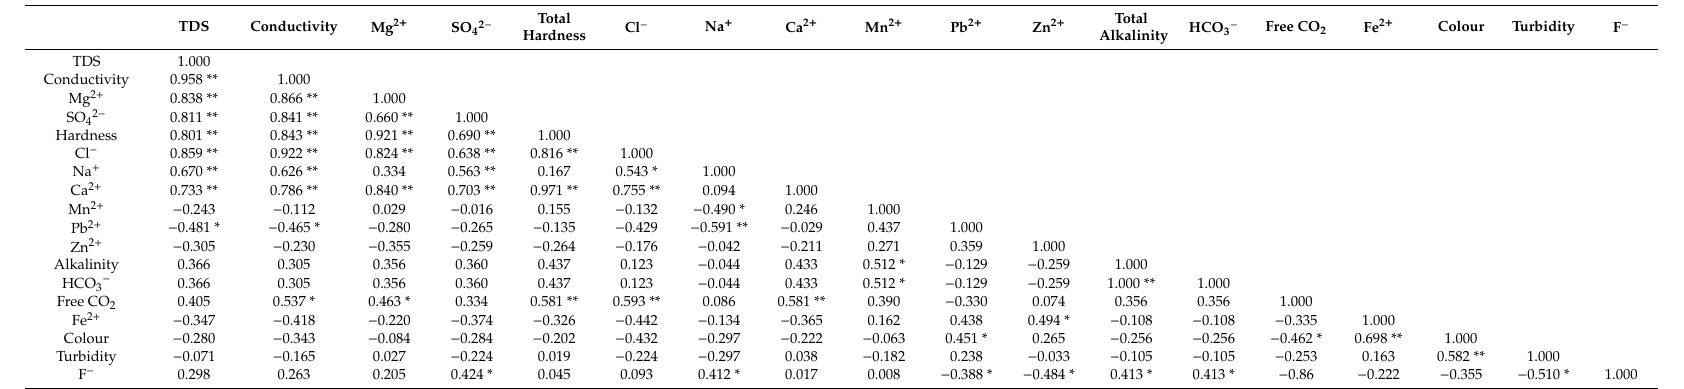
Table 4. Spearman’s correlation for the dominant physicochemical parameters in the study